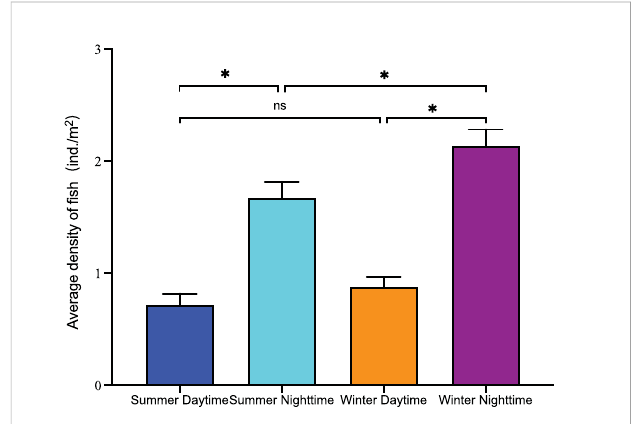
FIGURE 2 Mean density of four hydroacoustic surveys during different periods in Yudong Reservoir. Asterisks indicate signi fi cant correlations (p < 0.05), ns indicates no signi fi cant correlations (p > 0.05).